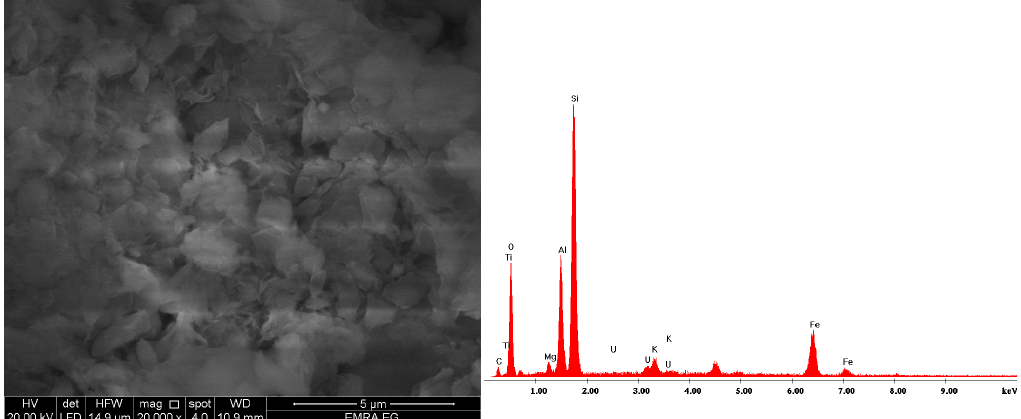
Figure 3. SEM images and EDX of U(VI) ions loaded HQ-bentonite.